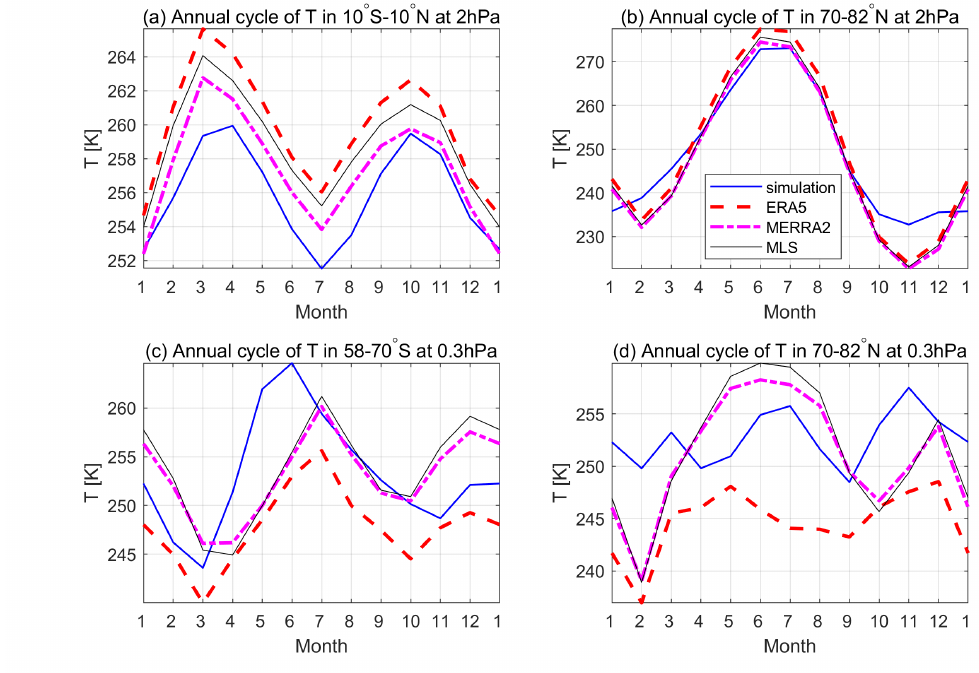
Figure 4. The monthly annual mean temperature at 2 hPa for the tropical region (10 ◦ S–10 ◦ N) ( a ), the NH high latitudes (70 ◦ N–82 ◦ N) ( b ), the SH high latitudes (58 ◦ S–70 ◦ S) ( c ) at 0.3 hPa and the NH high latitudes (70 ◦ N–82 ◦ N) at 0.3 hPa ( d ) in the period